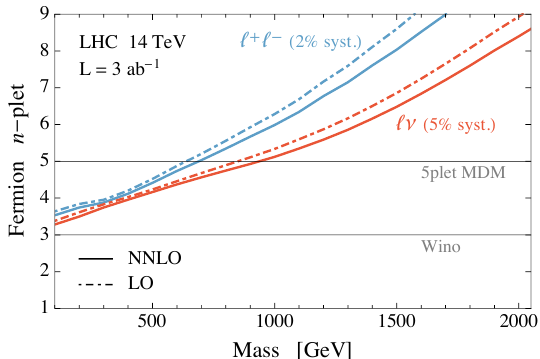
Figure 3 . Comparison of the 95% CL exclusion bounds on Majorana fermion multiplets at the HL-LHC obtained by using the LO (dot-dashed lines) and NNLO (solid lines) distributions. The blue lines refer to the ‘ + ‘ (cid:0) process, while the red ones correspond to the ‘(cid:23)